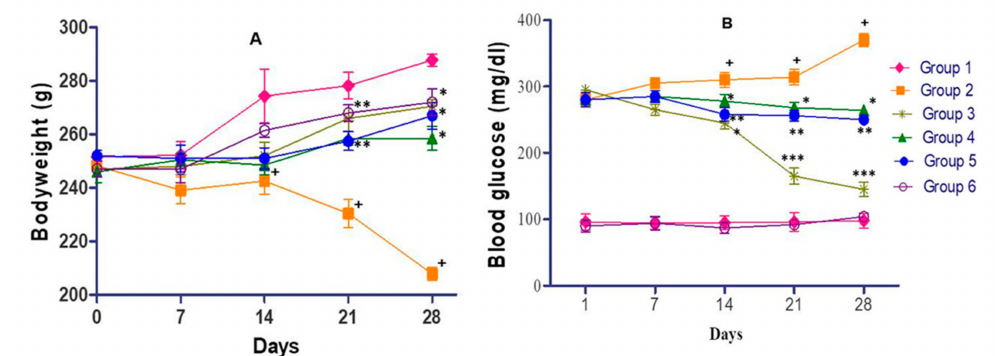
Figure 5. E ff ect of C. lanceolatus methanolic extract on body weight ( A ) and blood glucose level ( B ) of rats. The results are expressed as a mean ± SD ( n = 5). Group 1: Normal control; Group 2: Diabetic control; Group 3: Diabetic rats treated with glibenclamide; Group 4: Diabetic rats fed with C. lanceolatus extract (200 mg / kg); Group 5: Diabetic rats fed with C. lanceolatus extract (400 mg / kg); Group 6: C. lanceolatus extract (400 mg / kg) control. + p < 0.01 compared to normal control. * p < 0.05, ** p < 0.01 and *** p < 0.001 compared to the diabetic